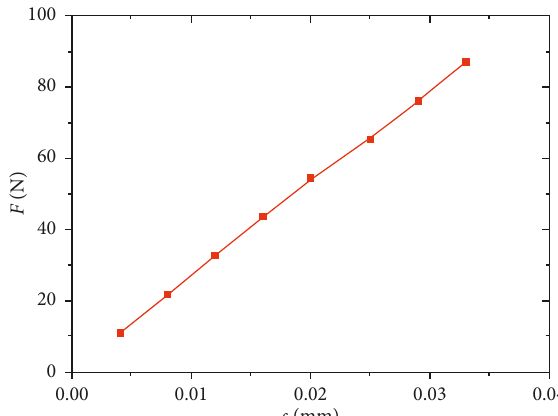
Figure 4: Force-displacement curve of the boring bar.